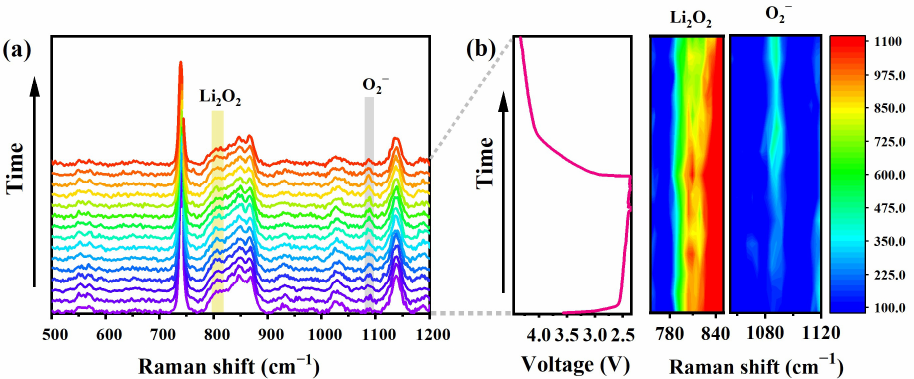
Figure 3. The in situ Raman spectrum of Pd–rGO catalyzed for Li–O 2 battery. ( a ) The in situ Raman overlay graph. ( b ) The in situ Raman mapping and corresponding voltage curves.